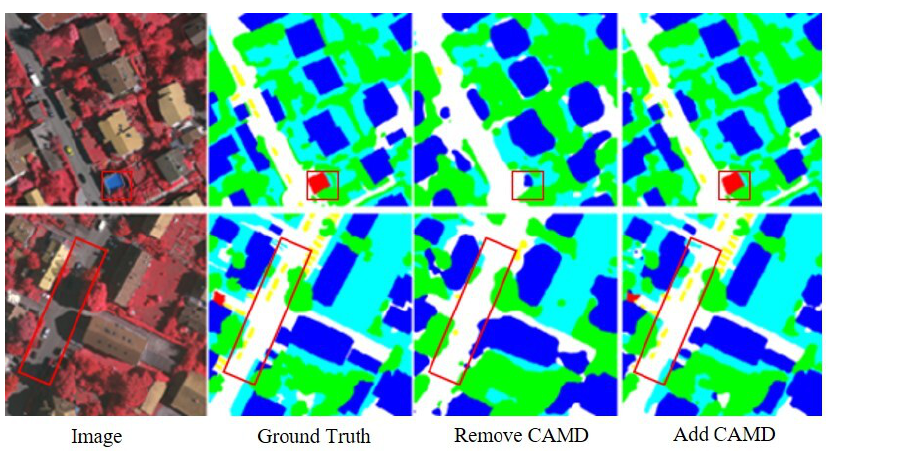
Figure 16. The effect of the CAMD on the remote sensing semantic segmentation results.